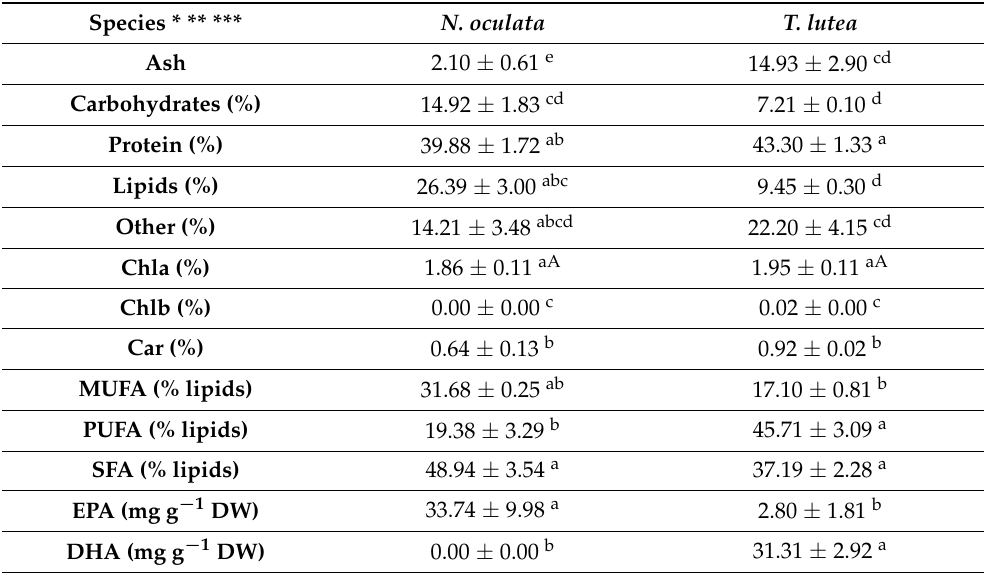
Table 3. Biomass composition, lipid analysis and EPA/DHA content of N. oculata and T. lutea during the early stationary phase. Values are given ± the standard